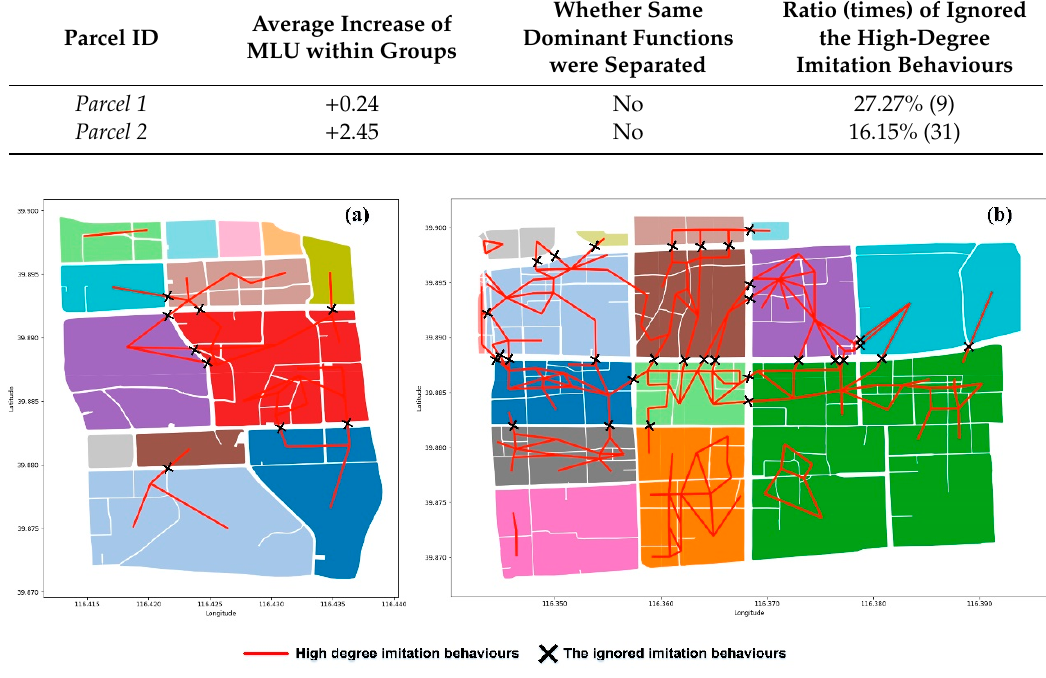
Figure 18. The ignored imitation behaviours among parcel group: ( a ) grouping result of Parcel 1 and ( b ) grouping result of Parcel 2 ( b ) grouping result of Parcel 2 . Table 5. Analysis of parcel grouping results based on infiltration behaviours (UPG).